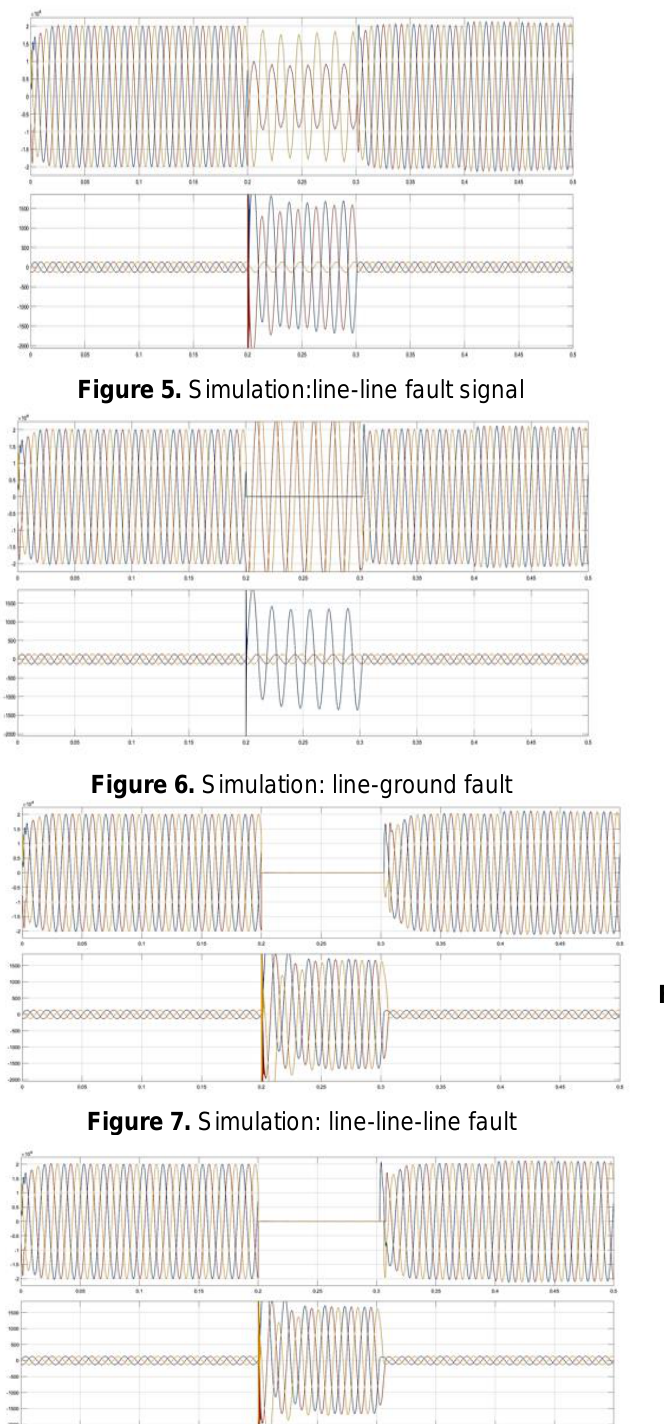
Figure 8. Simulation: line-line-line-ground fault Figure [7-10] indicates the four types of fault states in which the resulting current signal of the fault happens every 0.5sec. The error is 0.2 seconds, and the faults are evident from 0.3.